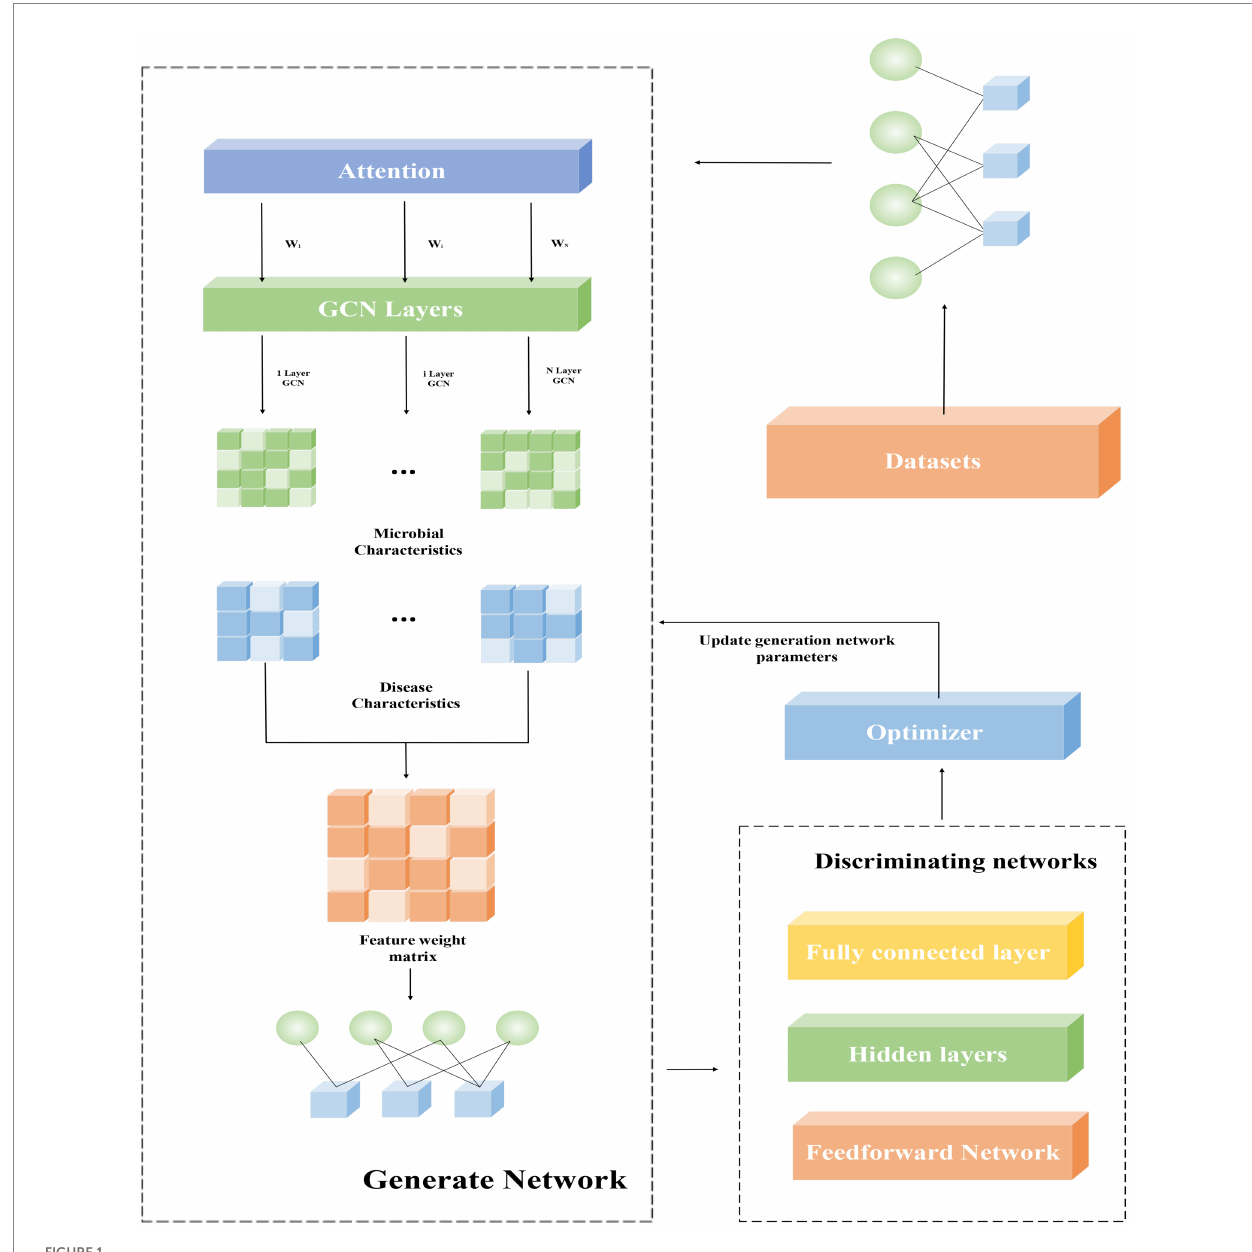
FIGURE 1 The general framework of the